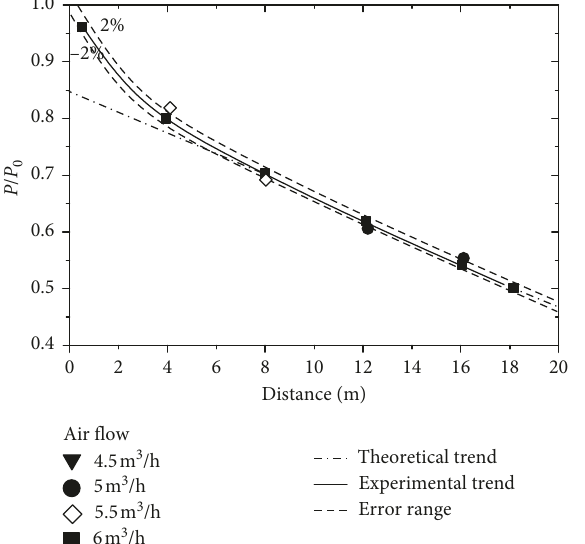
Figure 9: Normalization trend under different wind